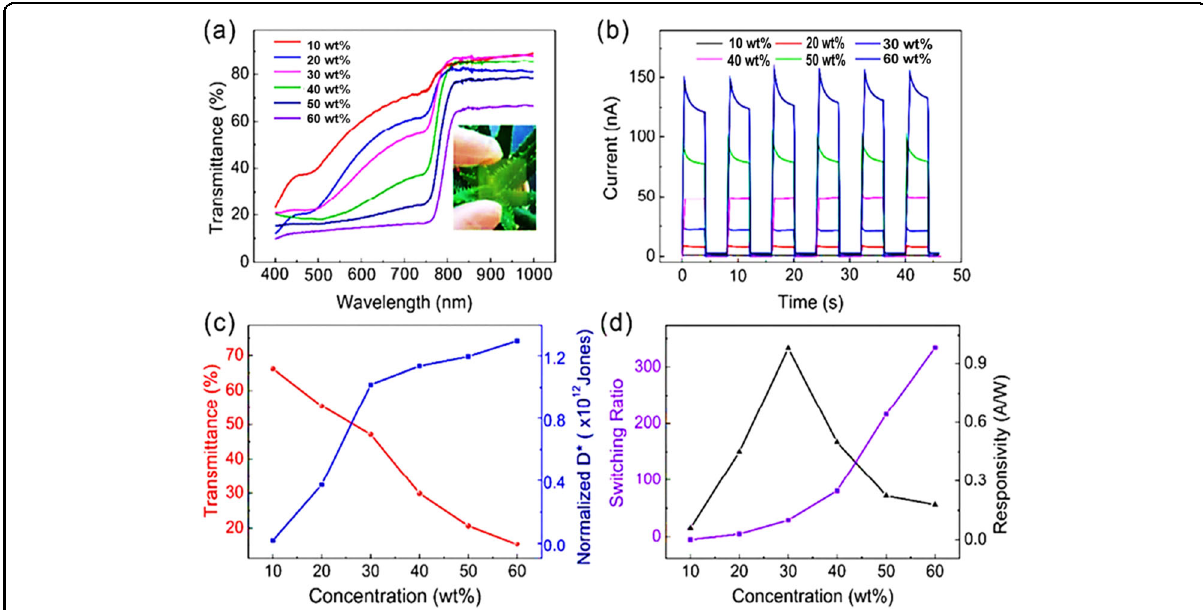
Fig. 8 Effect of the precursor concentration on MAPbI 3 NW-based PDs. a Transmittance of organolead triiodide perovskite networks as a function of the precursor concentration. b I - t curves for networked PD arrays. c Transmittance and normalized detectivity as a function of the precursor concentration. d Effect of precursor concentration on the responsivity and switching ratio. Reproduced with permission from ref. 86 . Copyright 2015, American Chemical